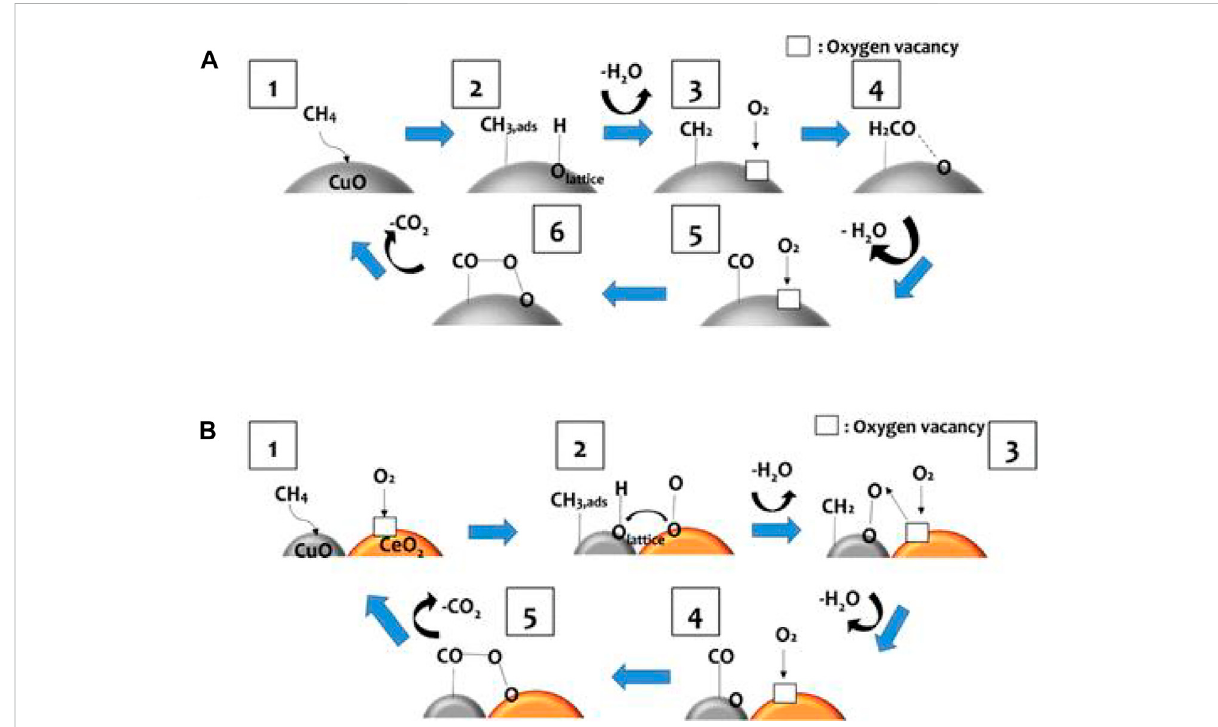
FIGURE 11 Cartoon depiction of methane combustion catalyzed by CuO (A) and Cu/CeO 2 (B) . Reprinted with permission from Lu et al. (2016). Copyright (2016) American Chemical Society.